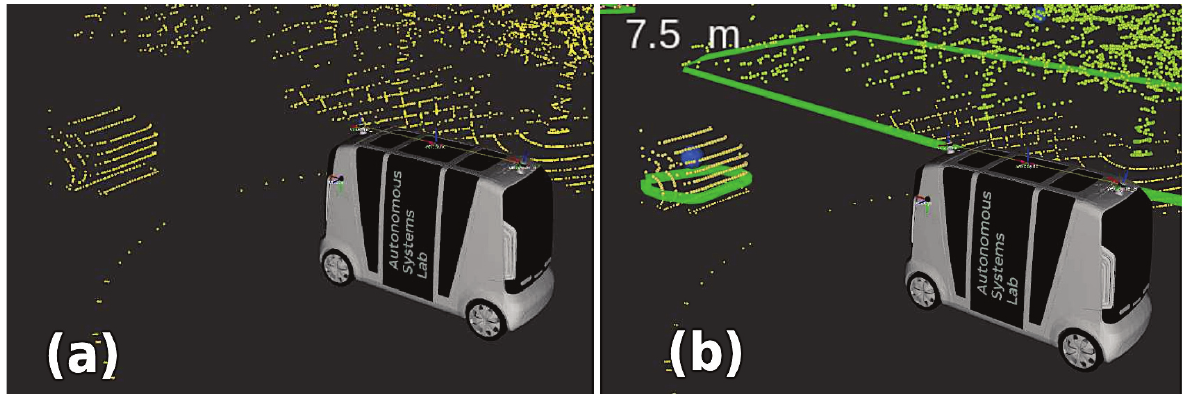
Fig. 6. (a) The ground filtering of the point-cloud and (b) applying of Euclidean